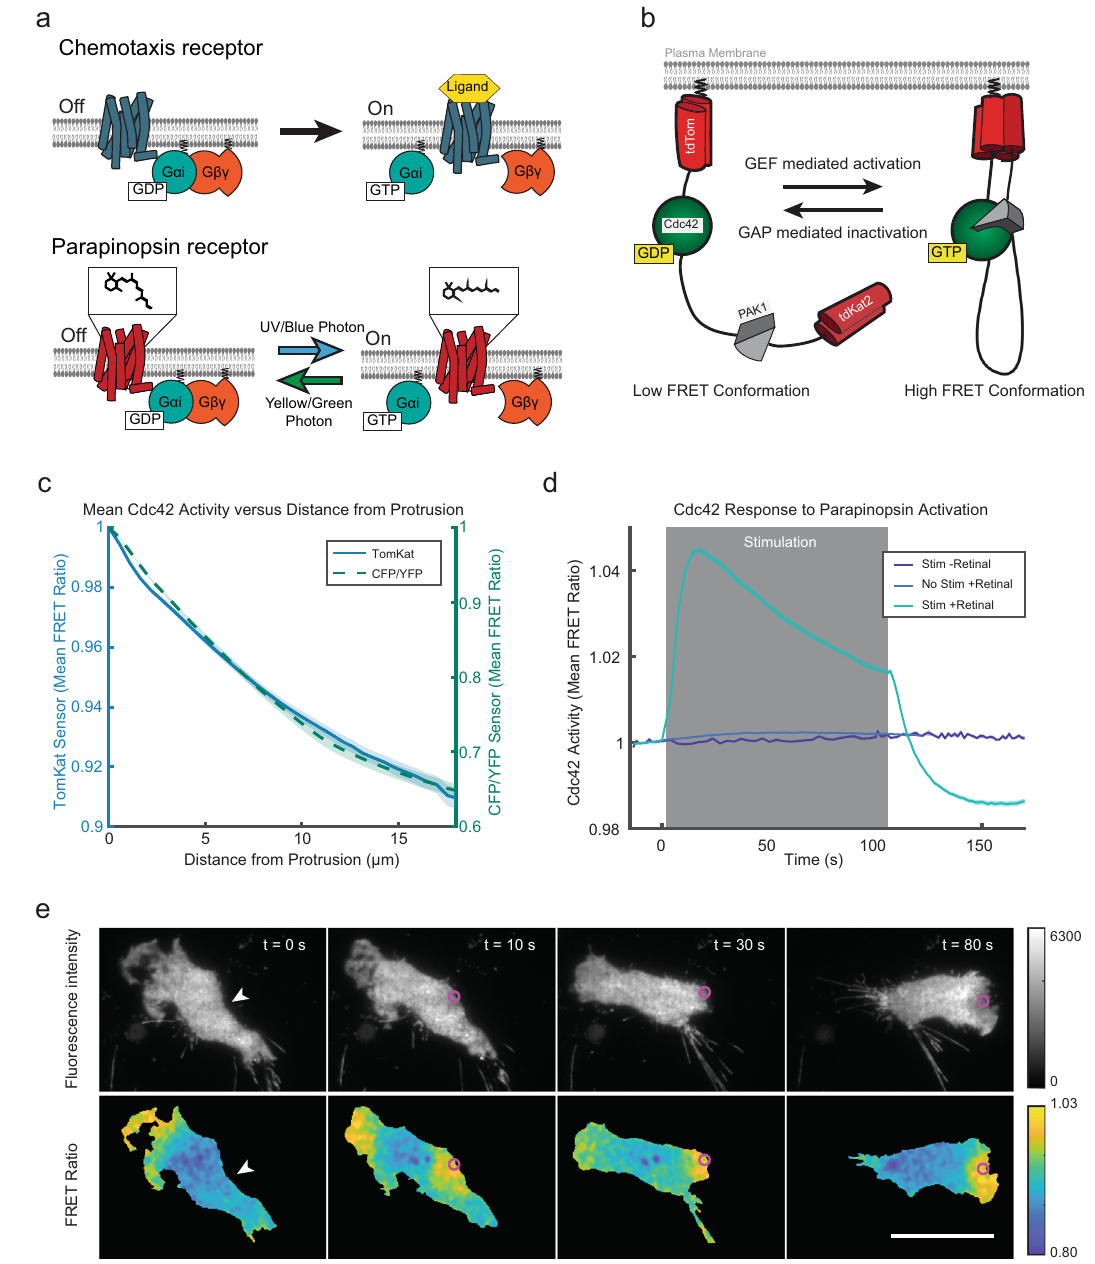
Fig. 1 A molecular toolkit for optical control of receptor activity and measurement of signaling outputs in the same cell. a Like chemoattractant receptors (above), the light-activated parapinopsina (below) is a G i α -coupled receptor. The chemical structure above the parapinopsina receptor represents the retinal chromophore that facilitates photon detection and receptor activation. Ultraviolet light photo-isomerizes 9- cis -retinal to all trans - retinal, activating the receptor. Longer wavelengths inactivate the receptor and photo-isomerize the retinal chromophore back to the cis -conformation. b Schematic for the TomKat fl uorescence resonance energy transfer (FRET) sensor that is spectrally compatible with parapinopsina. The FRET donor is td- Tomato, while td-Katushka2 is the FRET acceptor. The sensor contains the Cdc42 binding domain from PAK1 and a C-terminally truncated Cdc42 that are separated by a linker domain. The sensor C-terminus contains the K-Ras C-terminal polybasic region and CAAX motif, which anchor the sensor to the plasma membrane. c The spatial activity pro fi les were reported by TomKat and CFP/YFP FRET sensors in randomly moving differentiated PLB-985 cells. Data are presented as mean ± s.e.m. ( n = 73 cells for TomKat sensor and n = 59 cells for CFP/YFP sensor). d Cdc42 activity responses to global optogenetic receptor activation are dependent on light stimulation and 9- cis -retinal cofactor. The response rapidly attenuates after stimulations cease, indicating that the receptor is inactivated by imaging with longer (>530 nm) wavelengths of light. Data are presented as mean ± s.e.m. ( n well replicates = 19 for Stim-Ret, n well replicates = 31 for No Stim + Ret, and n well replicates = 59 Stim + Ret). Relative light intensity = 10. Time on the x -axis is relative to the last FRET image before stimulation. e Focal stimulation of the optogenetic-GPCR can repolarize a cell and drive a chemotaxis response. The white arrowheads indicate the target region pre-stimulus, while the magenta circles indicate the stimulated region. The Cdc42-TomKat sensor can be used to measure subcellular Cdc42 activity in the optogenetic receptor-stimulated cells. Scale bar, 25 µ m. Micrographs are representative of n = 141 cells. Source data are provided as a Source Data fi